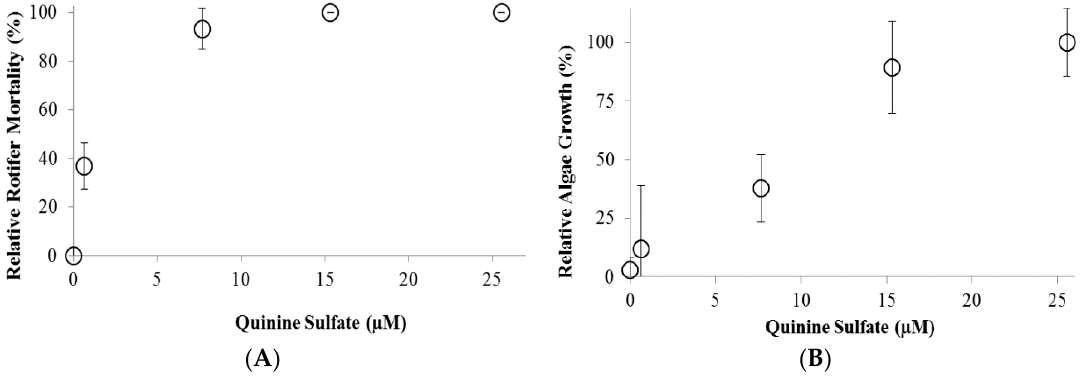
Figure 3. Effect of quinine sulfate (QS) on a co-culture of C. kessleri and B . calyciflorus . ( A ) Effect of quinine sulfate on B . calyciflorus . (Circles stand for the rotifer mortality at different quinine sulfate concentrations); ( B ) Effect of quinine sulfate on C. kessleri . (Circles stand for the algae growth rates at different quinine sulfate concentrations).